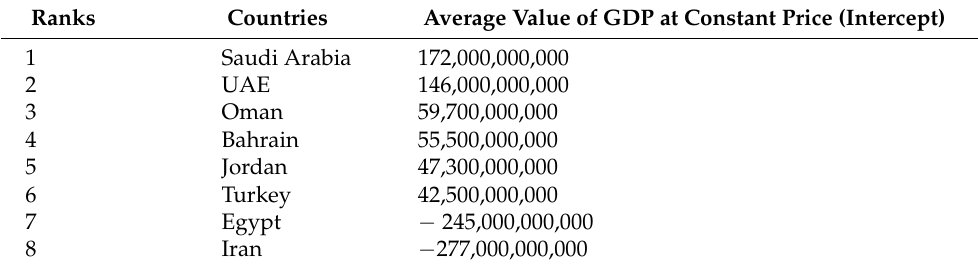
Table 8. Fixed effects between sections